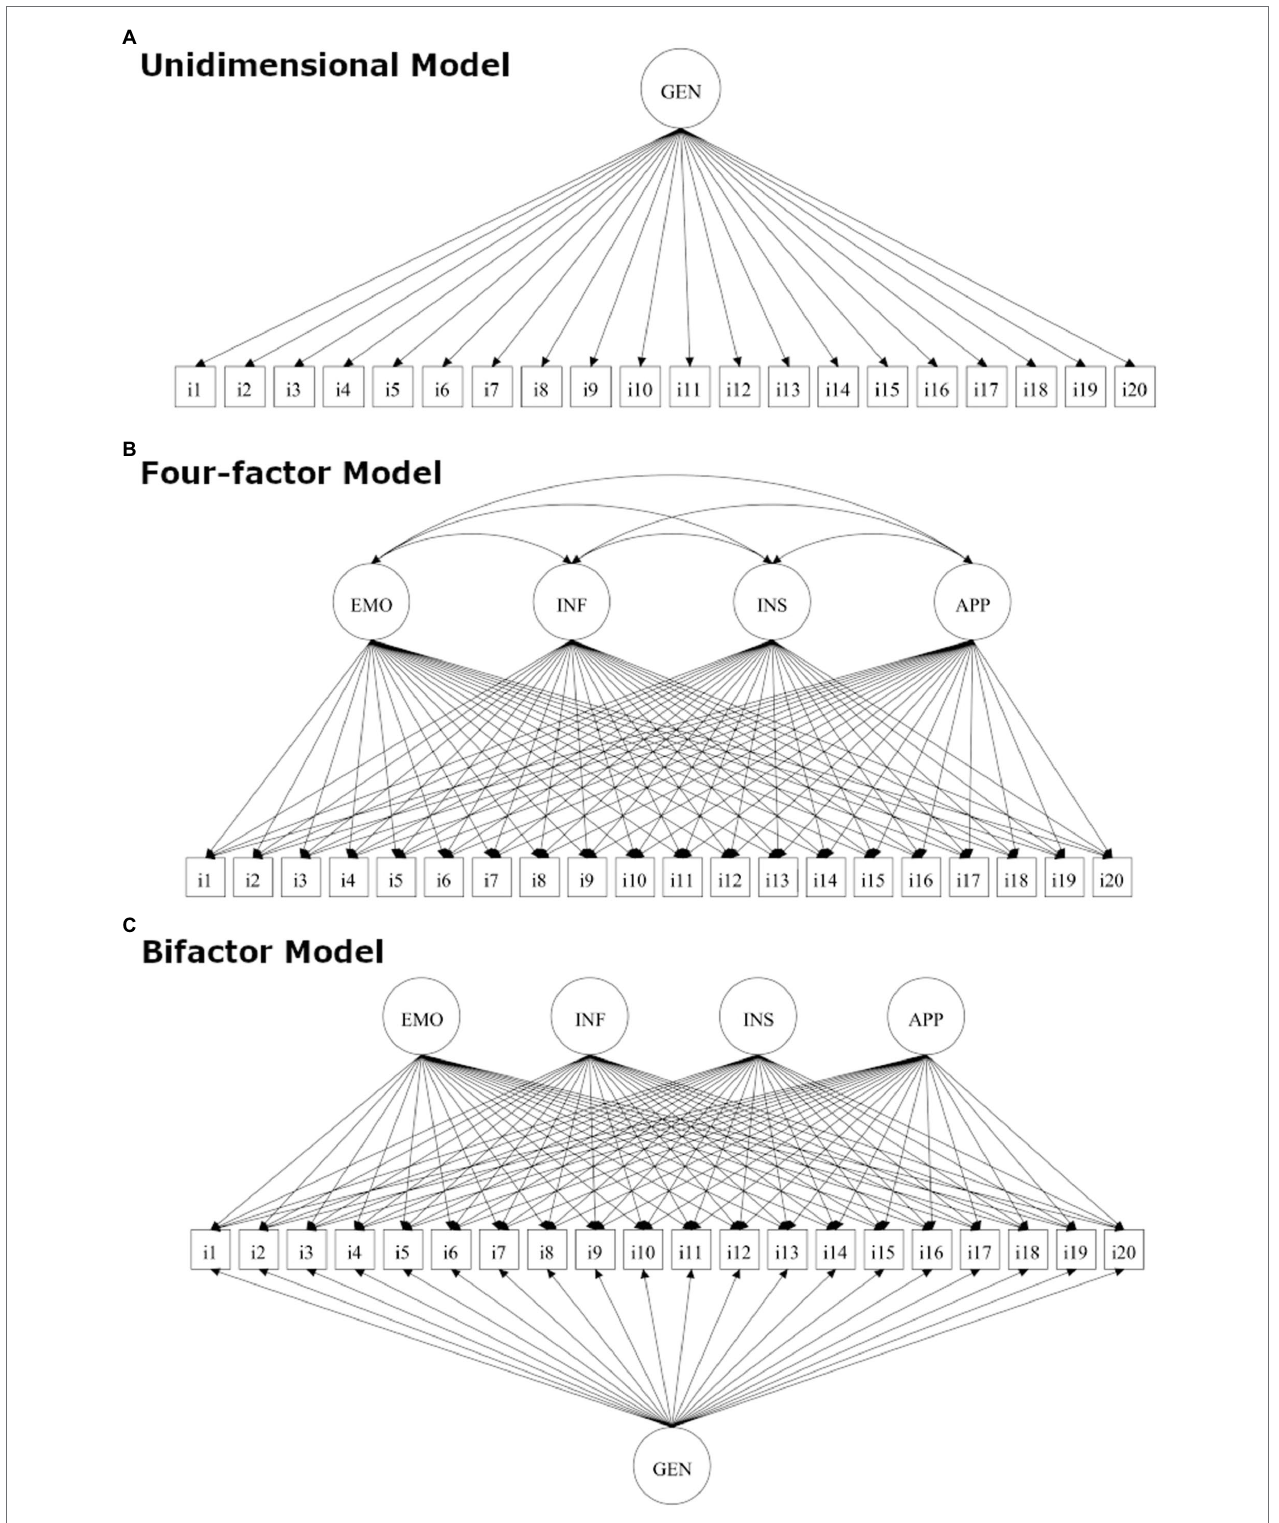
FIGURE 1 | Schematic representations of the models tested in the present study: (A) unidimensional model; (B) four-factor model; and (C) bifactor model. EMO, emotional support; INF, informational support; INS, instrumental support; APP, appraisal support; and GEN, general